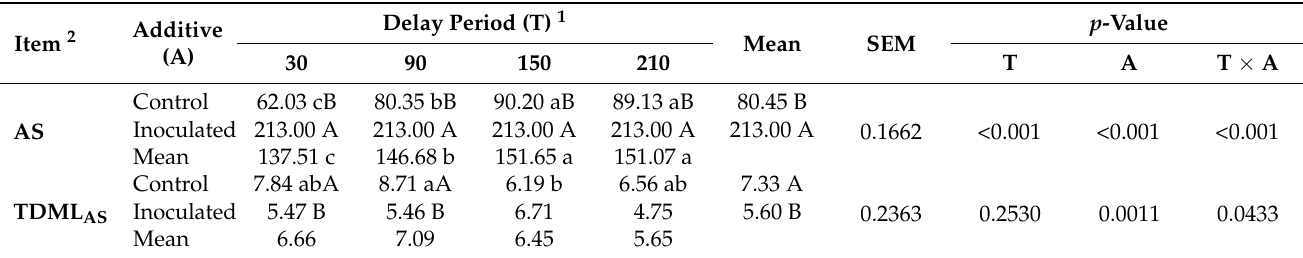
Table 4. Effects of delay period and inoculation on aerobic stability and on total dry matter loss during aerobic exposure.